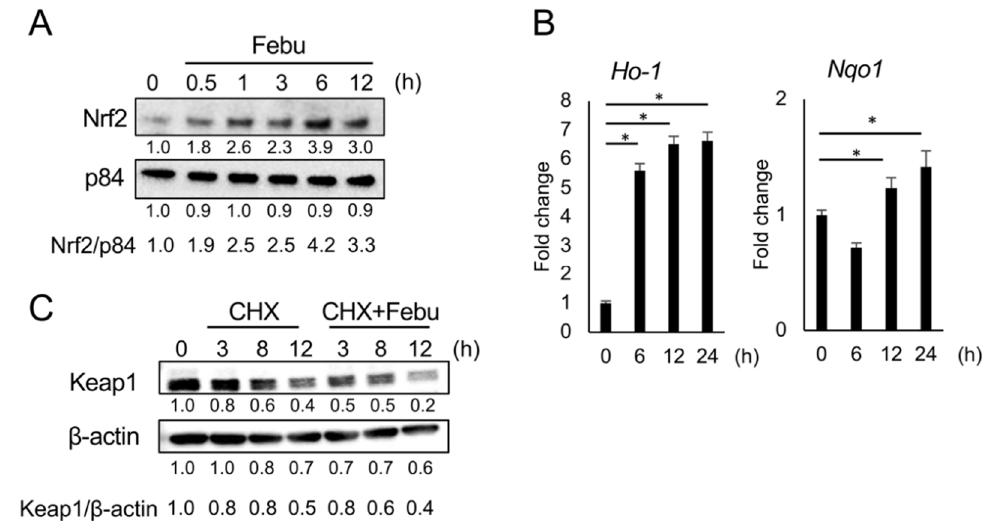
Figure 8. Febuxostat facilitates nuclear translocation of Nrf2 and degradation of Keap1 in MC3T3-E1 pre-osteoblastic cells. ( A ) MC3T3-E1 cells were cultured with Febu for the indicated time period. Nrf2 levels in the nucleus were analyzed by western blotting. p84 served as a loading control. Relative changes in the band intensities normalized by respective loading controls are indicated. ( B ) mRNA expression of Ho-1 and Nqo1 , the target genes of Nrf2, was determined using real-time PCR. Gapdh served as an endogenous control to normalize each sample. Data are expressed as the mean ± SD ( n = 3). * p < 0.05. ( C ) MC3T3-E1 cells were cultured in the presence of cycloheximide with or without Febu for the indicated time period. Keap1 levels were analyzed by western blotting. β -actin served as a loading control. Relative changes in the band intensities normalized by respective loading controls are indicated.